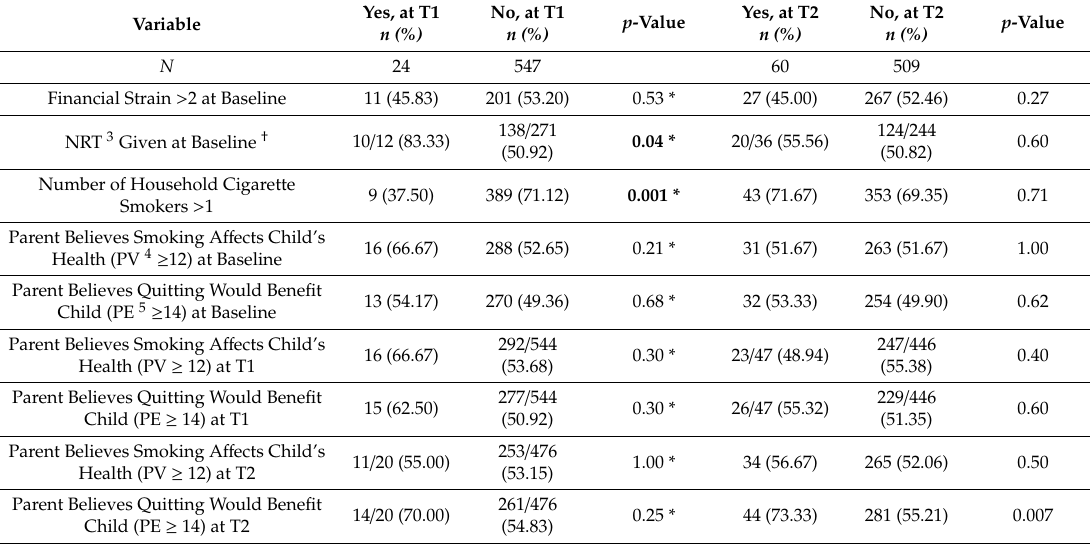
Table 3. Self-reported abstinence at T1 1 and T2 2 for specific